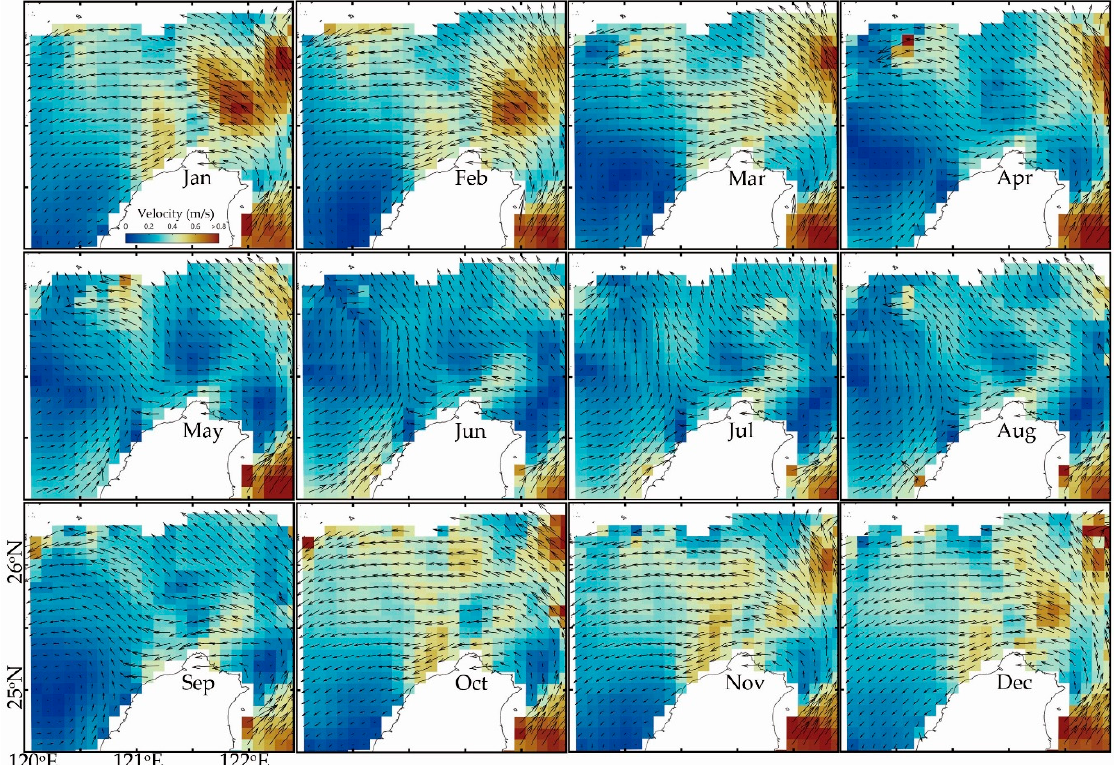
Figure 10. Monthly CODAR flow field during the flood period from December 2014 to May 2020.